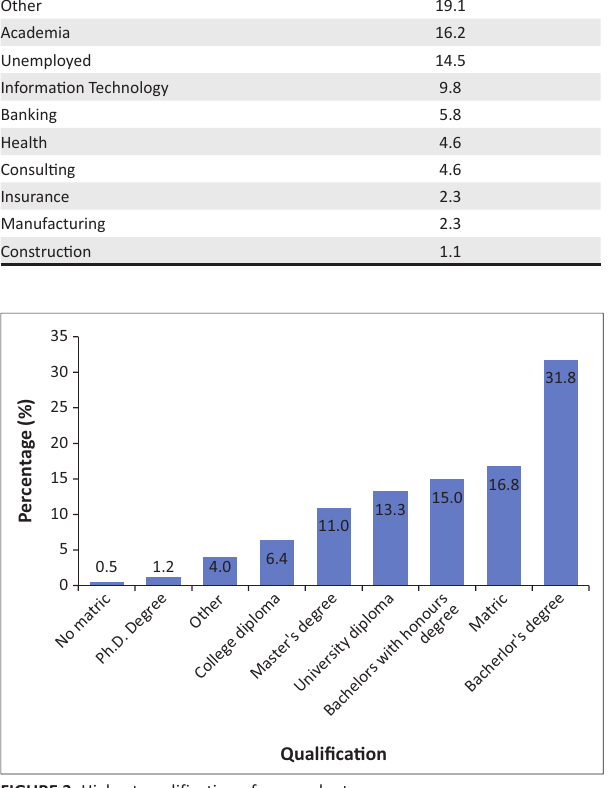
FIGURE 3: Highest qualification of